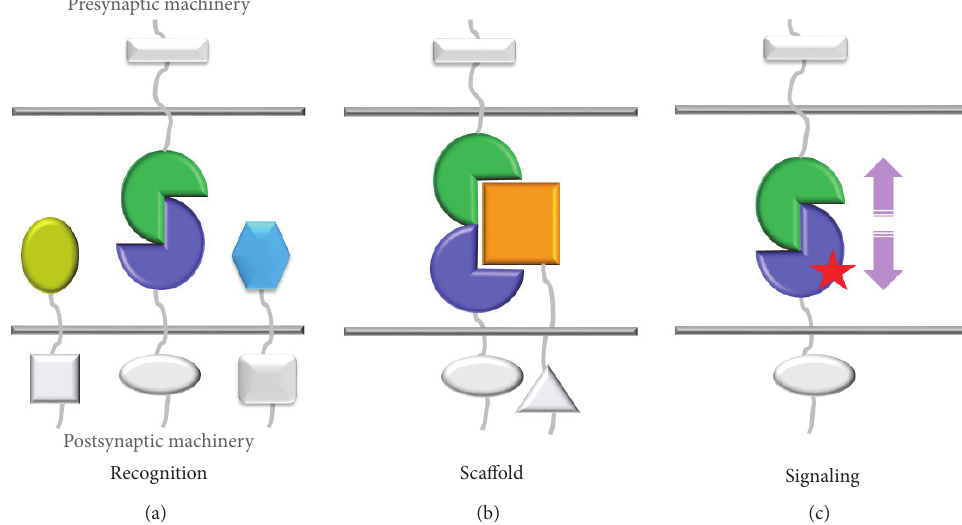
Figure 2: SAM function and mechanisms. SAMs can recruit and organize protein interaction networks in the synaptic cleft by (a) generating mechanisms to recognize specific SAM partners, but not others by binding through direct interactions; (b) binding other SAMs to generate a scaffold onto which a third protein can dock and this mechanism also supports the binding of SAMs through indirect interactions; (c) binding a partner and inducing a signaling event, for example, through (allo)steric